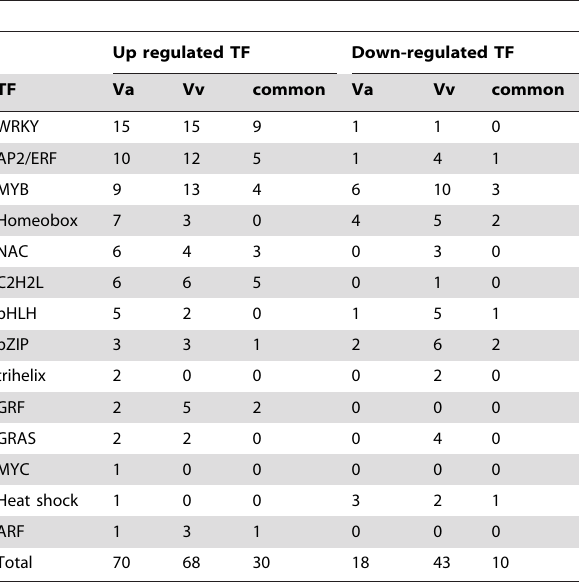
Table 6. Differential expressed transcription factors in V. amurensis and in V. vinifera cv. Muscat of Hamburg.